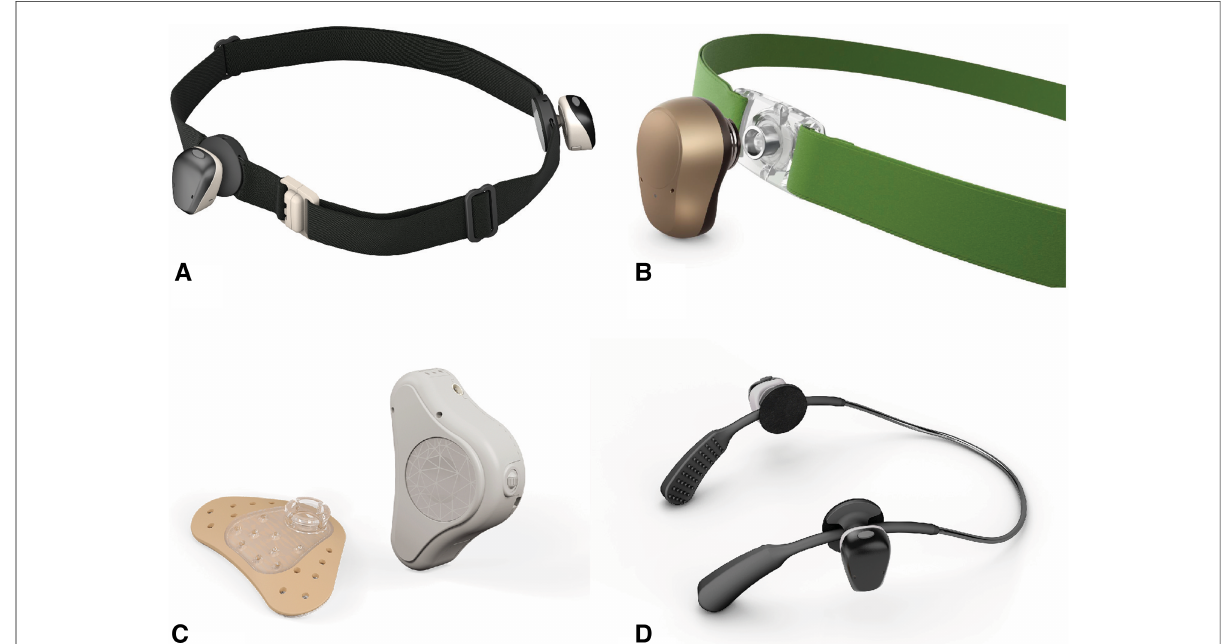
FIGURE 5 Non-Surgical Bone Conduction Devices. Bone conduction sound processors. ( A ) Cochlear BAHA ® with softband. ( B ) Ponto ® with softband. ( C ) Med- El ADHEAR ® with adhesive gel pad. ( D ) Cochlear BAHA SoundArc ®